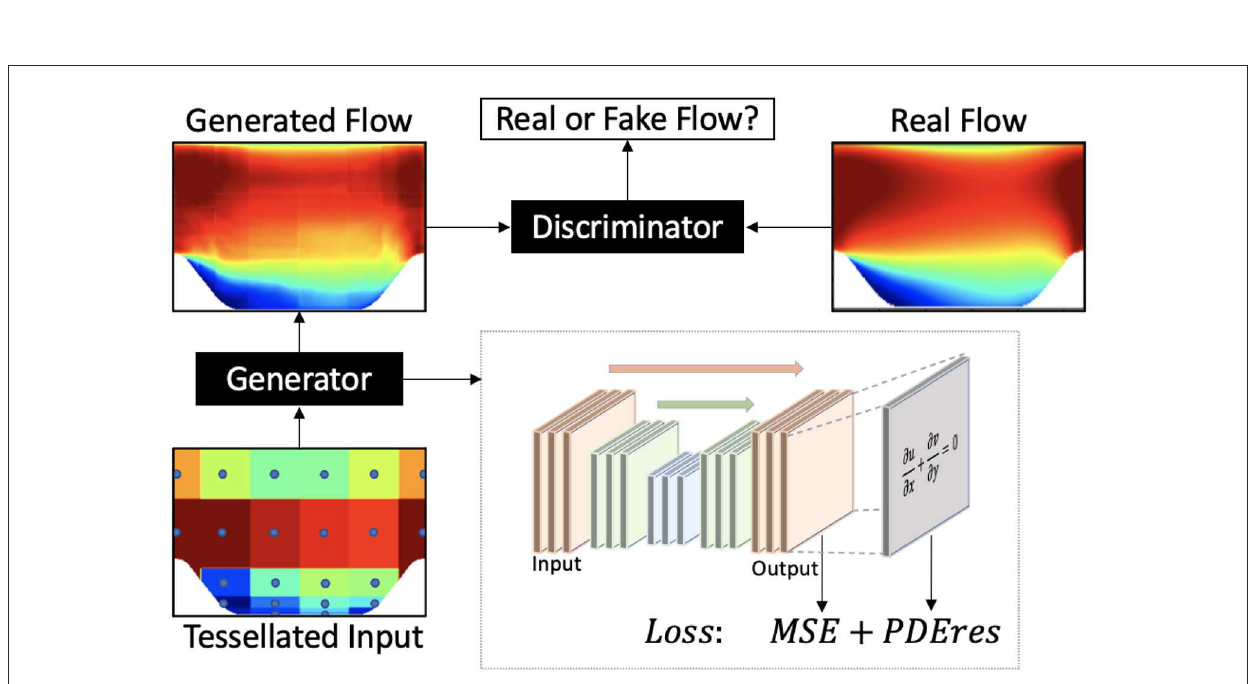
FIGURE2 Overview of a single iteration of the training routine for the regular GAN model with weak-PI loss. The tessellated variables are input into the generator network (see Figure 1), which can utilize a combined residual and physics-informed loss function. The generated SR output is checked by the discriminator to be a real or fake flow, and the entire model is trained iteratively in this adversarial